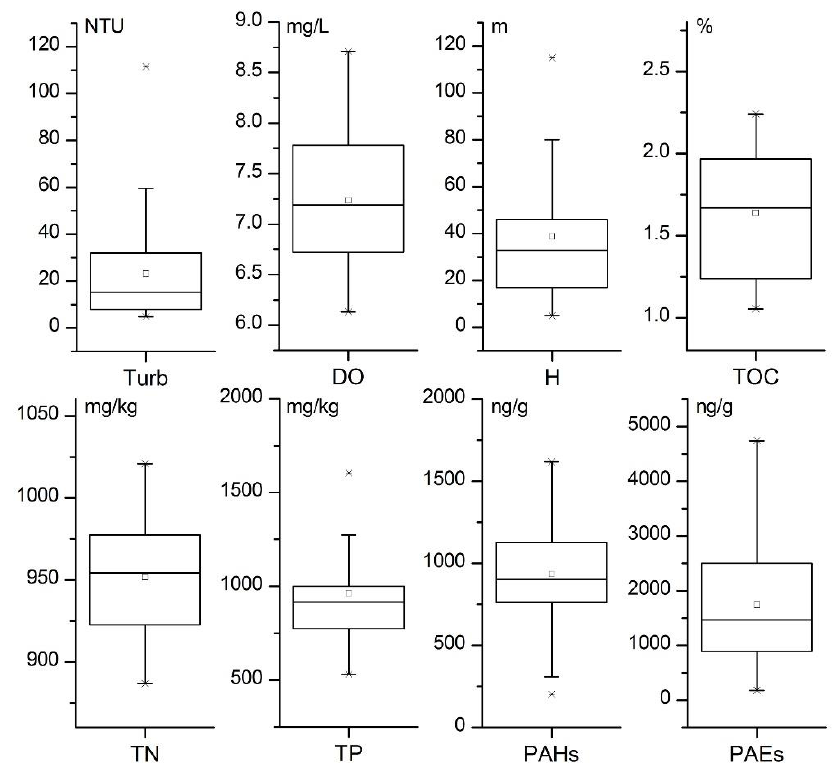
Figure 3. Box plots of the measured physical and chemical environmental variables, including the turbidity, dissolved oxygen (DO), and water depth ( H) of the bottom water samples, and the total organic carbon (TOC), total nitrogen (TN), total phosphorus (TP), and the total polycyclic aromatic hydrocarbons (PAHs) and phthalic acid esters (PAEs) of the surface sediment samples.